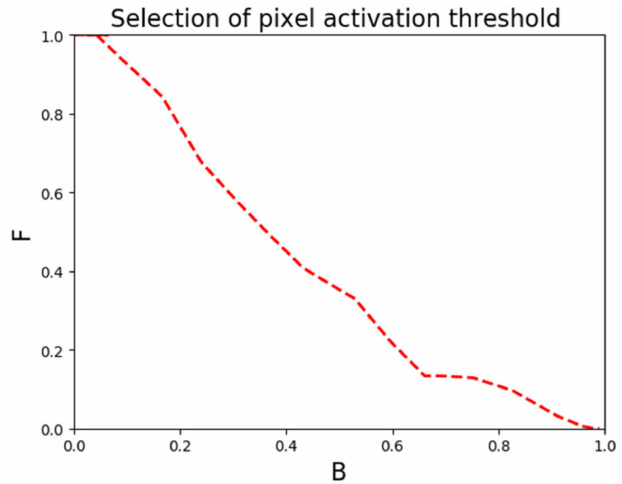
Figure 4. Selection of pixel activation